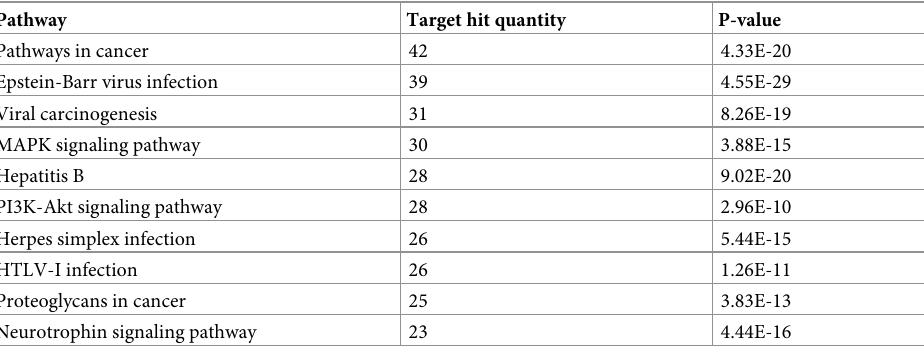
Table 3. The detail of the top 10 pathways in the target-pathway interactive network.